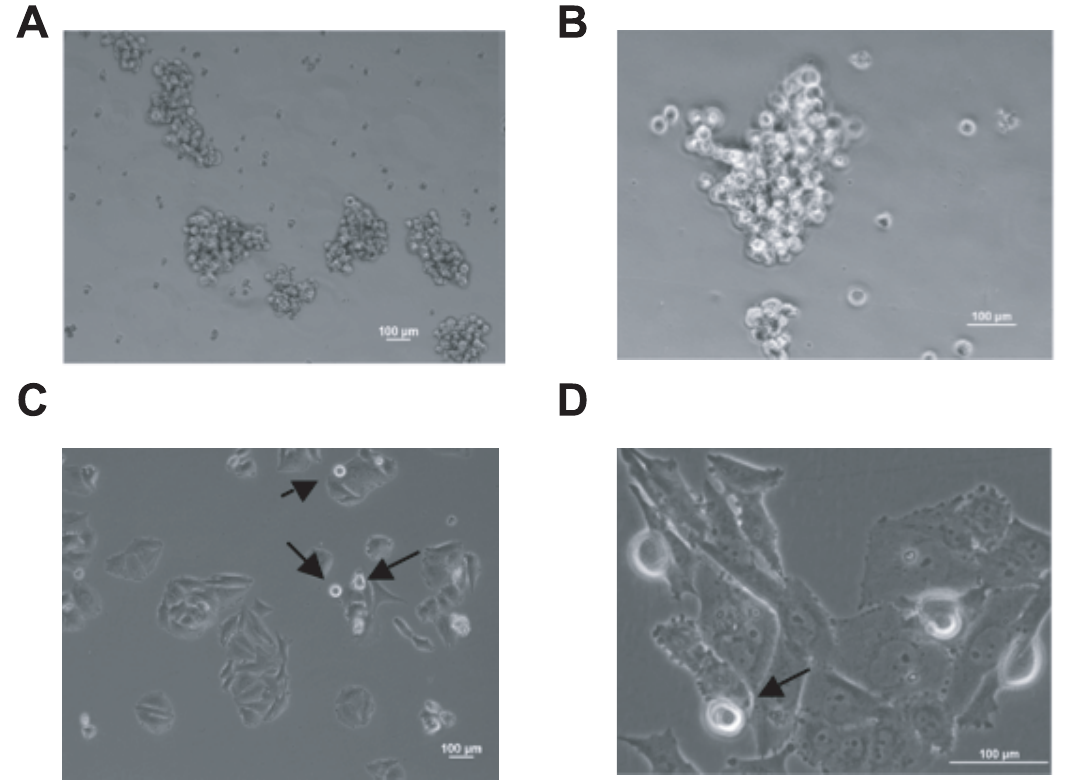
Figure 4. Phase contrast images of spheres formed by HFB SAOS-2 CD133( + ) enriched osteosarcoma cells. A ) HFB grown SAOS-2 osteosarcoma cells (CD133 + ) are able to proliferate and assemble three-dimensionally as sarcosheres after 3-days of culture in the bioreactor (10 6 magnification). B ) HFB grown SAOS-2 osteosarcoma cells (CD133 + ) are able to proliferate and assemble three-dimensionally as sarcosheres after 3- days of culture in the bioreactor (40 6 magnification). C ) HFB grown SAOS-2 osteosarcoma cells (CD133 + ) seeded into an irradiated plastic culture dish, reconstitute the normal attached phenotype of the parental SAOS-2 cells after one week of culture (10 6 magnification). Arrows point at CD133( + ) SAOS-2 cells showing a rounded and weakly attaching phenotype. D ) HFB grown SAOS-2 osteosarcoma cells (CD133 + ) seeded into